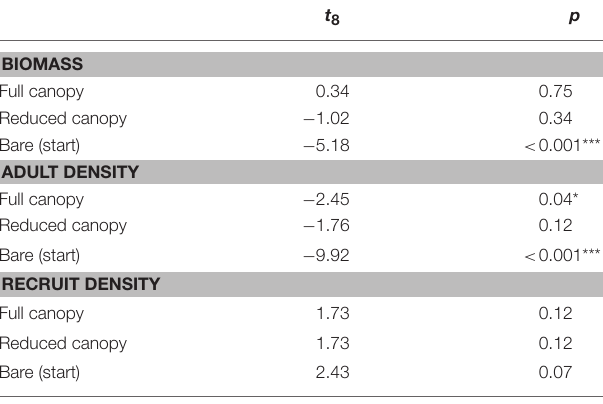
TABLE 2 | Summary of two-sample t -tests comparing “Pre-experimental” macroalgal biomass, adult and recruit density to each treatment.